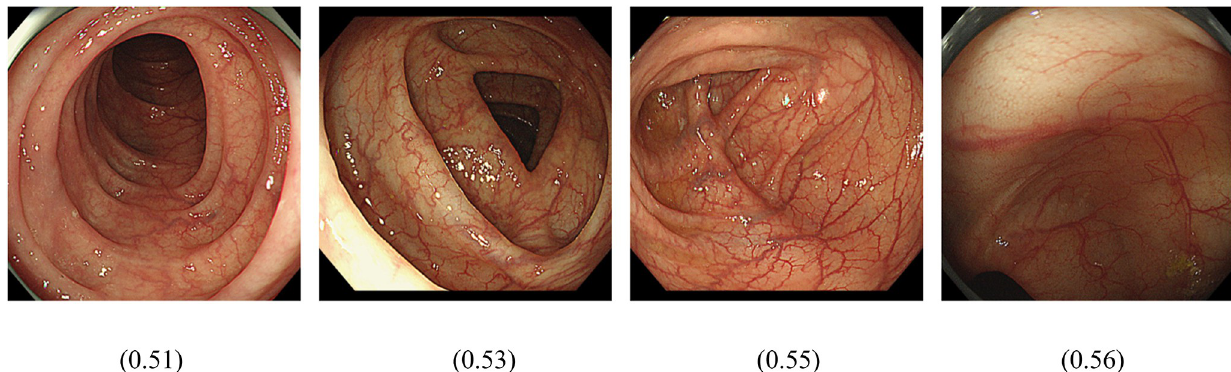
Fig 2. Images that scored relatively high (0 to 1) in the colon image AI model for detecting Group I are shown. Values shown correspond to score.